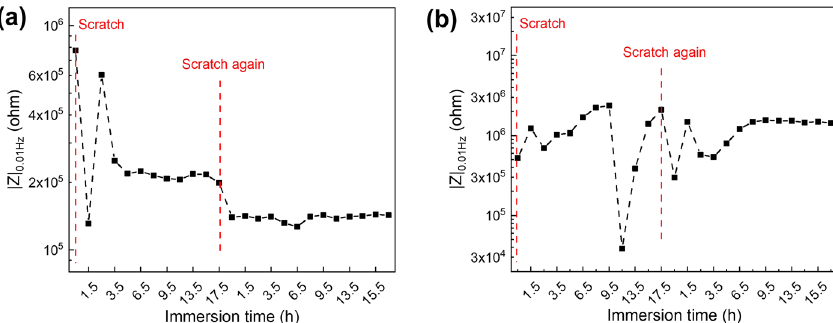
Fig. 9 EIS measurements on scratched coated samples. Evolution of |Z | 0.01Hz of the scratched epoxy coating containing a Ce(NO 3 ) 3 -loaded microspheres and b Ce(NO 3 ) 3 -loaded nano fi bers. The coated samples were immersed in 100 mM